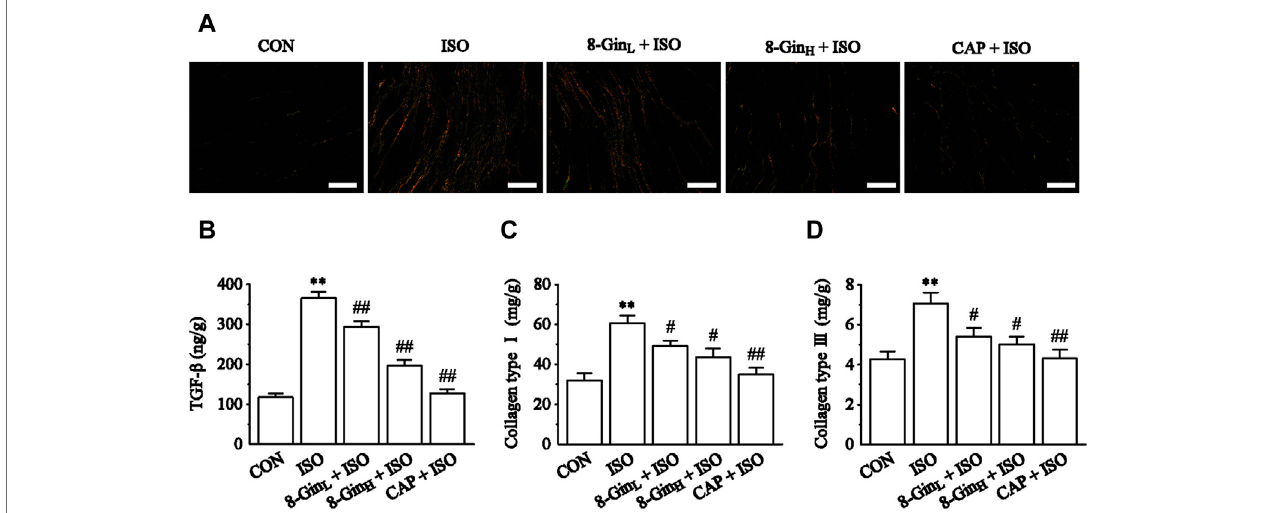
FIGURE 4 | Effects of 8-Gin on Sirius red staining and collagen types I and III. (A) Representative Sirius red staining histologic slices in fi ve groups of CON, ISO, 8-